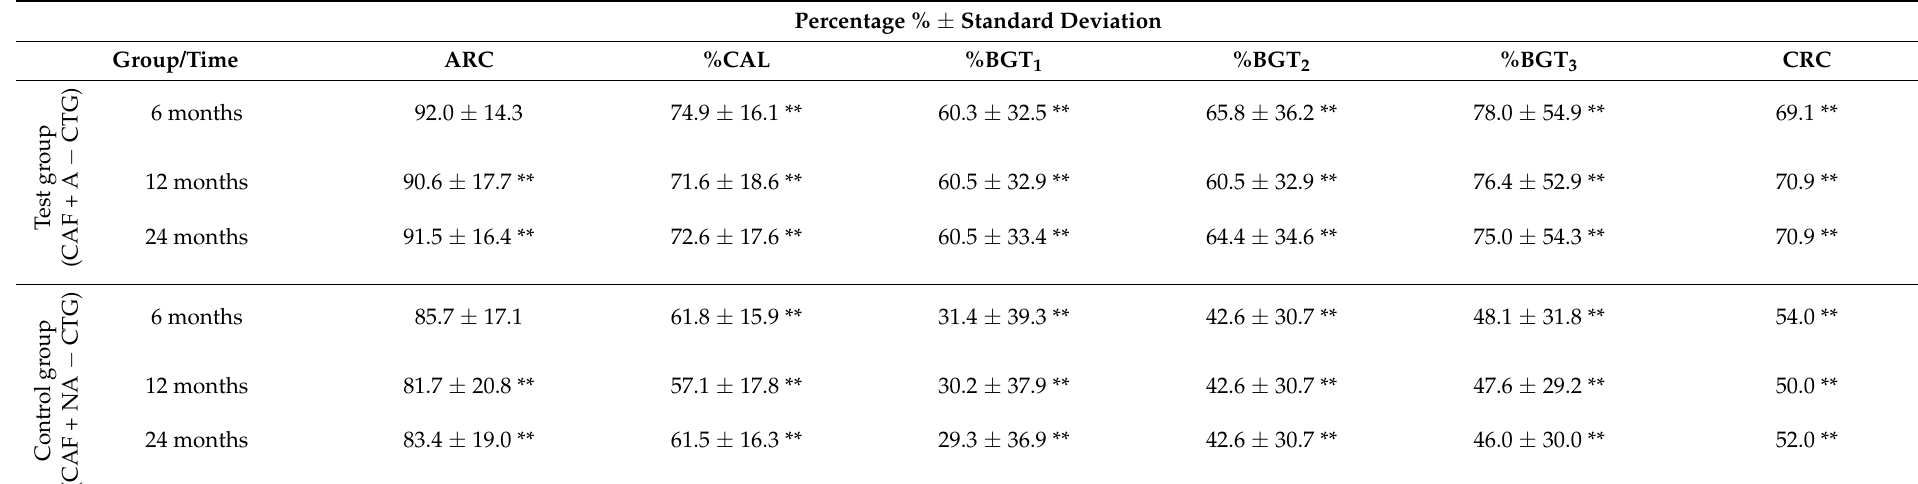
Table 3. Descriptive statistics recorded between 6, 12 and 24 months